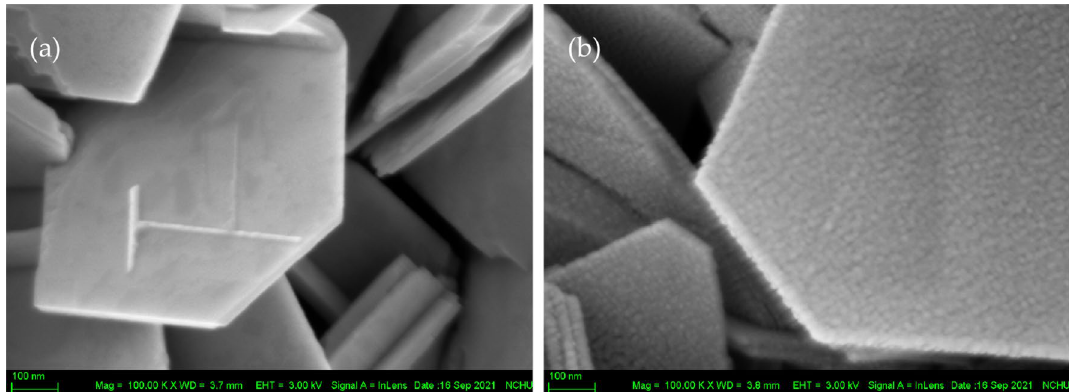
Figure 1. FESEM images of ( a ) pristine and ( b ) Au180s-decorated Bi 2 Se 3 NPs.